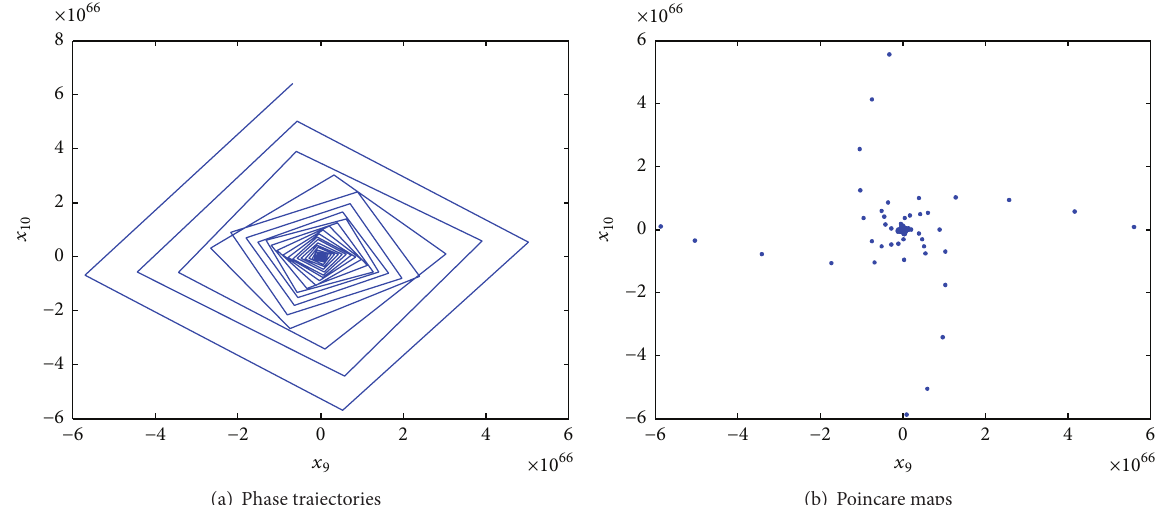
Figure 15: 𝜔 = 262 with random perturbation.